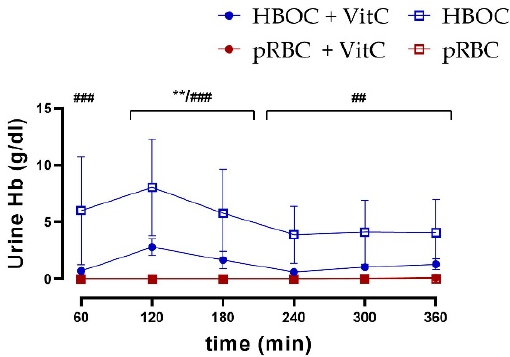
Figure 7. Hemoglobin concentration in urine was significantly higher in the HBOC group than in the pRBC and pRBC + VitC groups (HBOC + VitC vs. pRBC + VitC; ** p < 0.01, HBOC vs. pRBC; ## p < 0.01, ### p < 0.001).